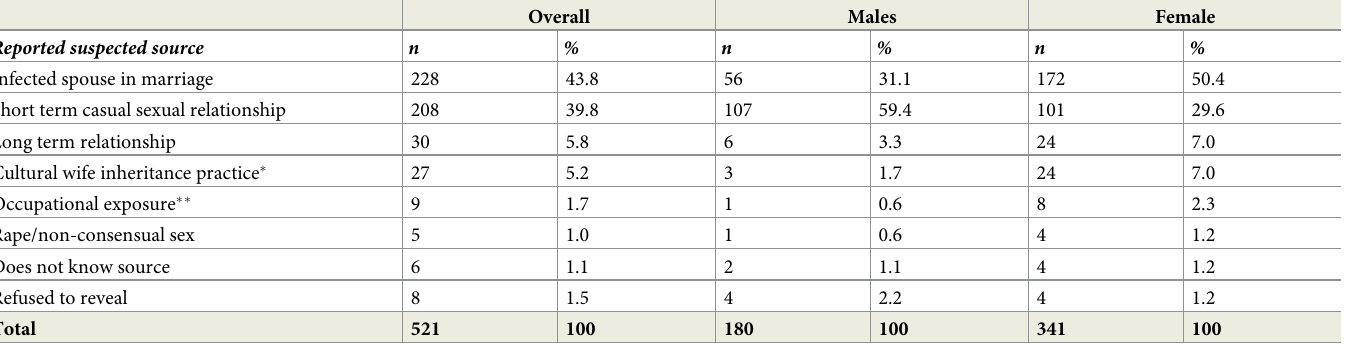
Table 4. Overall and by gender, the reported suspected source of infection among the 521 seroconverters who participated in the survey and responded to this question. Overall Males